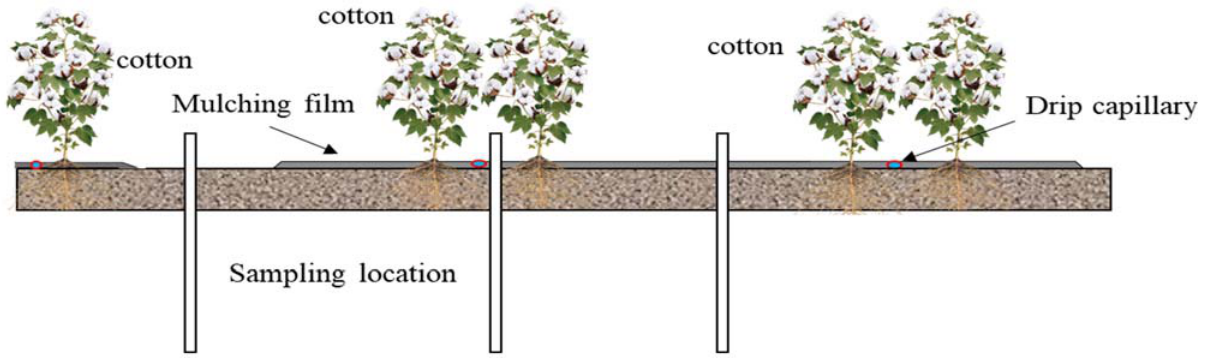
Figure 2. Planting mode with one membrane, two tubes, and four rows.